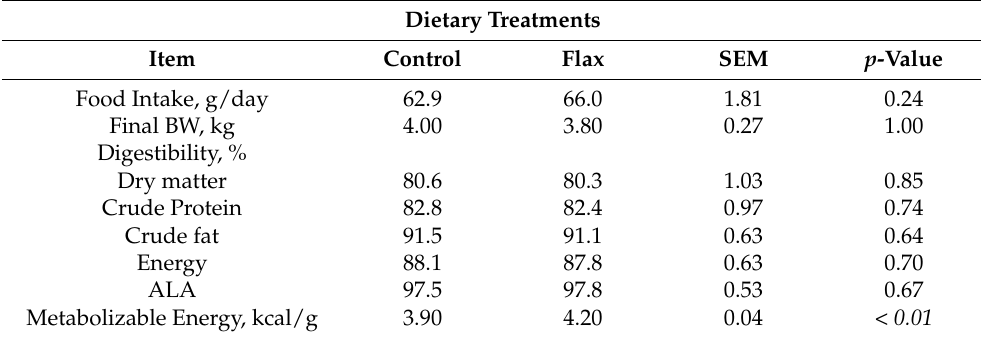
Table 2. Average weekly food intake, final body weight, and total-tract apparent nutrient and ALA